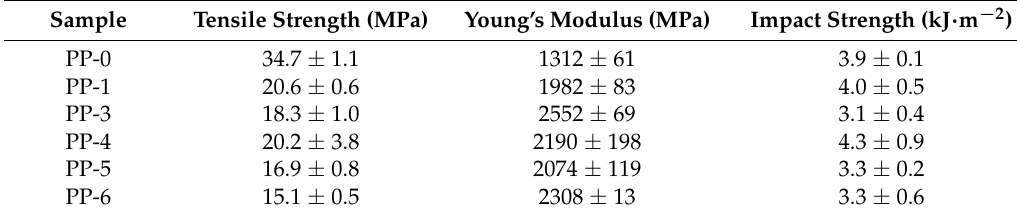
Table 3. Mechanical properties of the PP